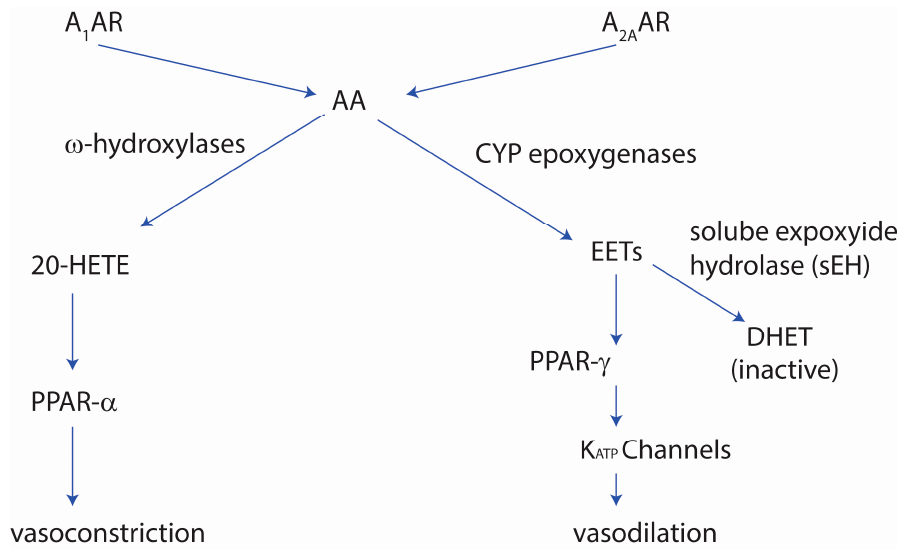
Figure 1. The role of adenosine receptors in vascular tone regulation. See text for details. A 1 AR: adenosine A 1 receptor; A 2A AR: adenonsine A 2A receptor; AA: arachidonic acid; 20-HETE: 20-hydroxyeicosatetraenoic acid; EETs: epoxyeicosatrienoic acids; and DHETs: dihydroxyeicosatrienoic acids.